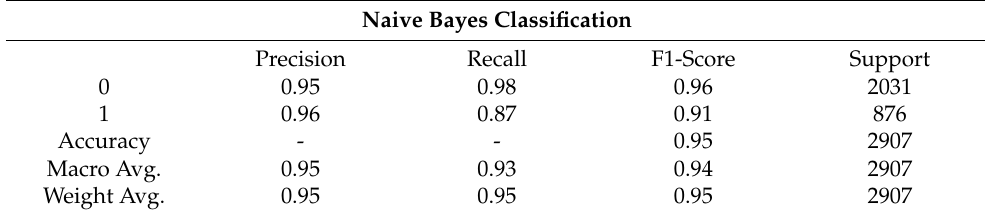
Table 4. Naive Bayes classification